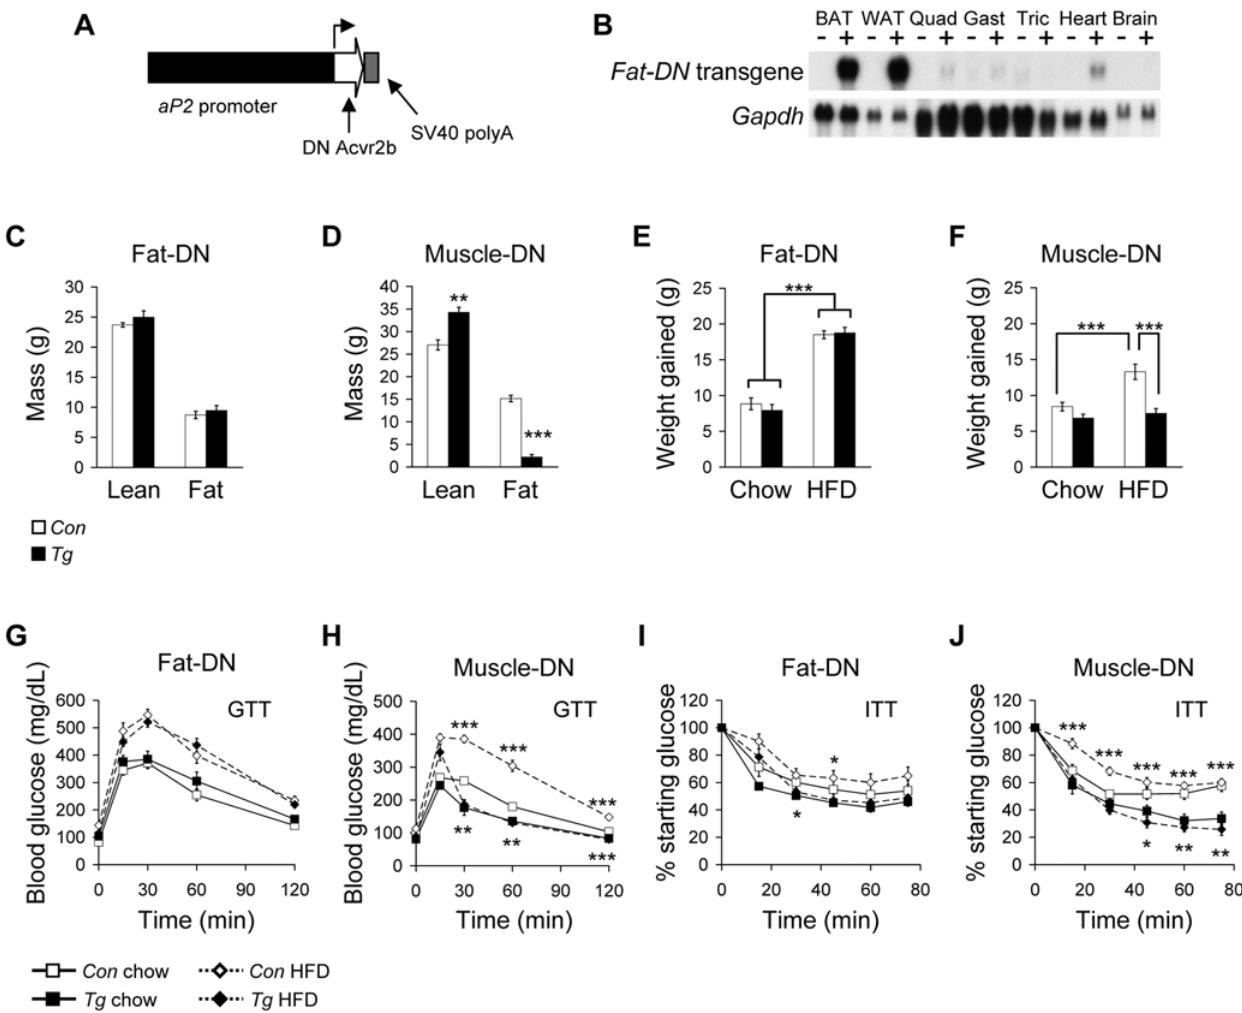
Figure 5. Tissue-specific inhibition of myostatin signaling. ( A ) Diagram of the construct used to make fat-DN transgenic mice with the aP2 promoter controlling expression of a truncated Acvr2b containing the extracellular ligand binding and transmembrane domains. ( B ) Northern blot analysis of expression of fat-DN transgene and Gapdh loading control from different tissues from non-transgenic ( 2 ) and transgenic ( + ) mice. Body composition of ( C ) fat-DN ( n =10–11) and ( D ) muscle-DN ( n =5) male mice compared to non-transgenic littermates. Lean and fat mass are shown as absolute values. Body weight gained by ( E ) fat-DN ( n =9–17) and ( F ) muscle-DN ( n =9–14) male mice and littermate controls after 10 weeks on diets. Blood glucose levels during GTT of ( G ) fat-DN ( n =7–8) and ( H ) muscle-DN ( n =9–14) male mice and littermate controls on standard chow and HFD. Percent of starting glucose during ITT of ( I ) fat-DN ( n =7–8) and ( J ) muscle-DN ( n =9–12) male mice and littermate controls on standard chow and HFD. * P , 0.05, ** P , 0.01, *** P , 0.001. G – J , P value symbols are for comparisons between genotypes on the same diet; below curves, mice on standard chow; above curves, mice on HFD.